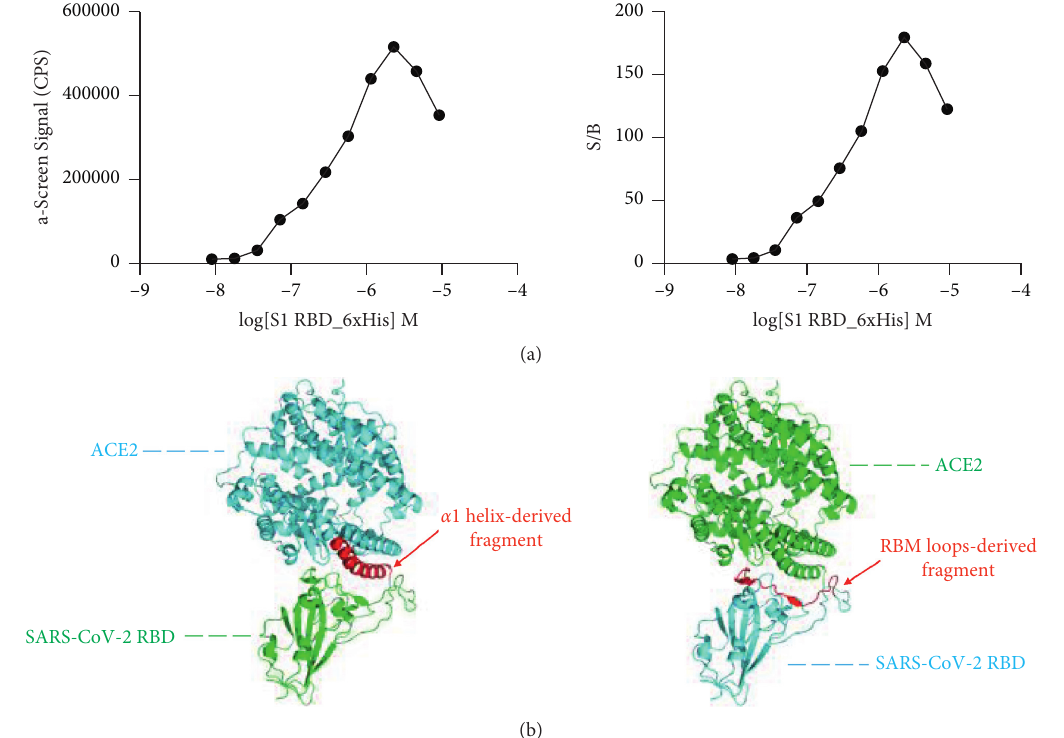
Figure 2: Optimization of assay and design of peptides. (a) Titration of 6xHis-tagged S1 RBD against a fixed concentration of biotin-tagged ACE2 ( ∼ 20 nM) (left). Maximal value was obtained at the hook point before diminishing in signal. Signal-to-background ( S / B ) ratios at each given concentration used in the titration (right). (b) Interface of the ACE2 and RBD interaction and regions targeted for the rational derivation of peptide fragments (shown in red) that inhibit the binding of the two